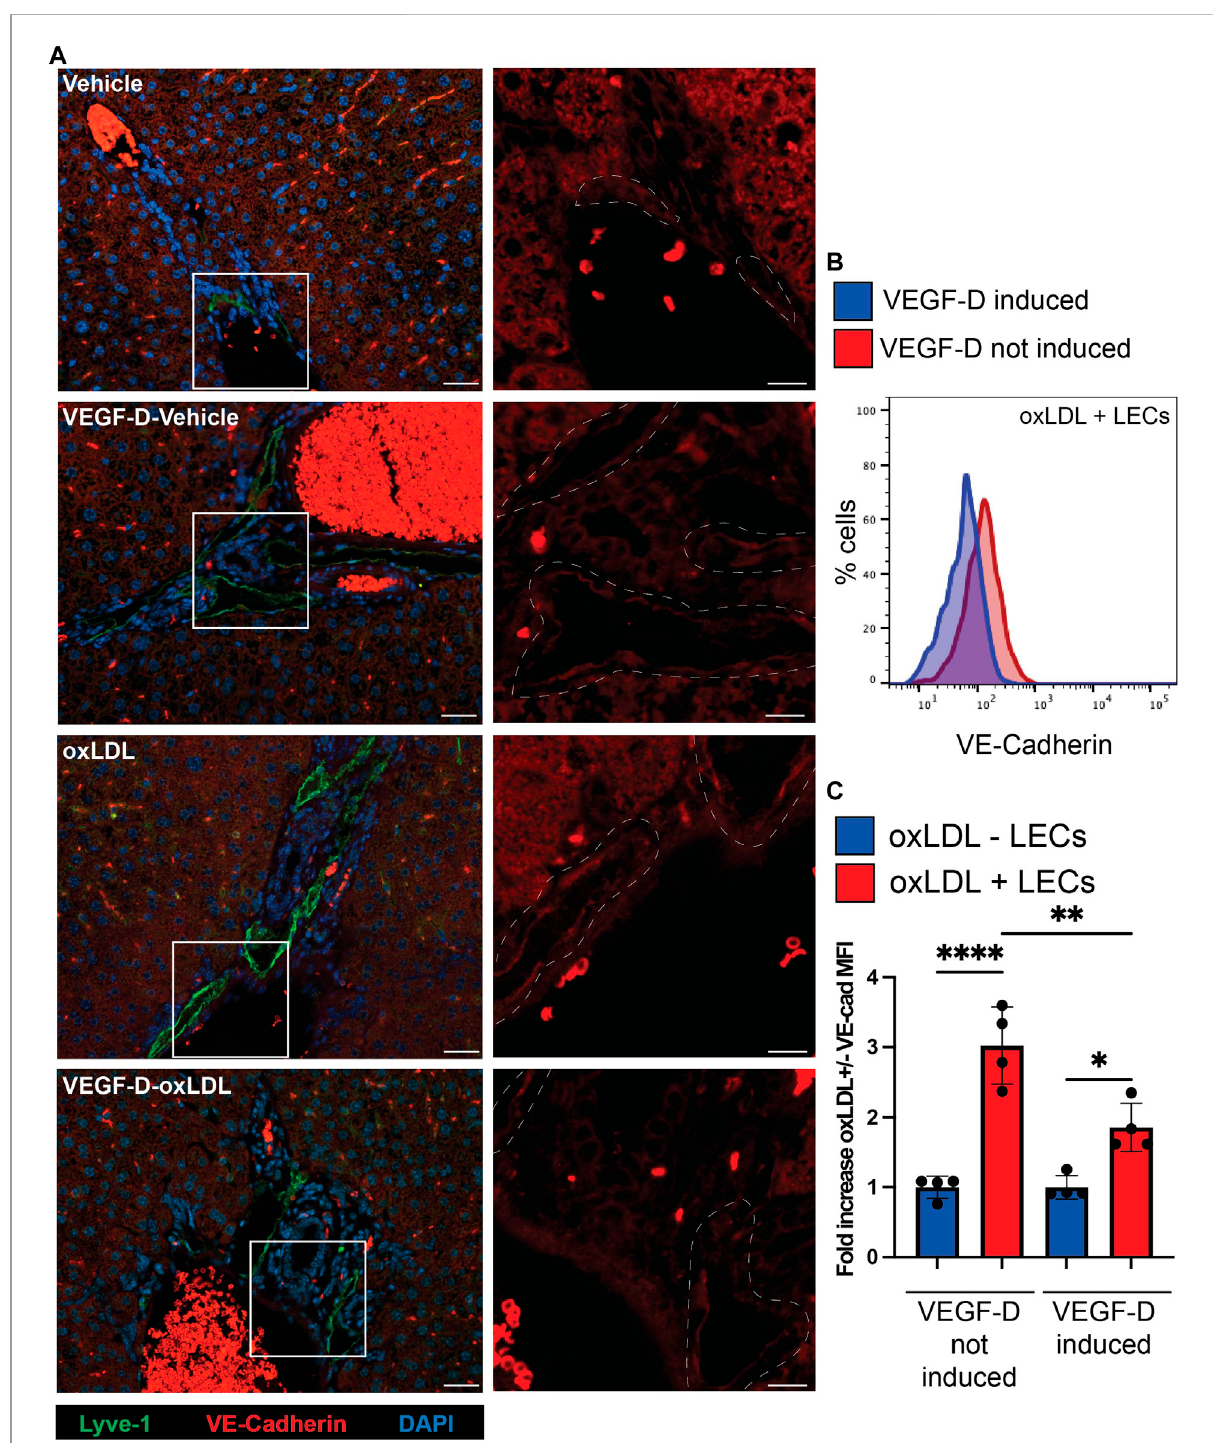
FIGURE 5 oxLDL increased VE-Cadherin in liver lymphatics is decreased by VEGF-D induction in vivo . (A) Mice were treated exactly as in Figure 4A. Non- induced mice were wild-type mice treated with doxycycline, VEGF-D mice were TRE-VEGF-D mice treated with doxycycline. Mice were injected with either PBS or oxLDL as described in methods. Liver tissue sections were stained with VE-Cadherin (red), Lyve-1 (green) and Dapi (blue). Scale bars on zoomed out images are 20 μ m and scale bars on zoomed in VE-Cadherin only images are 10 μ m. Dashed white lines indicate areas of lyve-1/lymphatic staining. 3-5 liver sections from 2 experiments were stained and imaged. (B) TRE-VEGF-D mice treated with doxycycline water for 2 dayspriortooxLDL-DILinjection.4 – 6